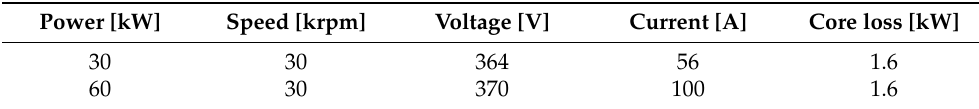
Table 3. Characteristics of 30 krpm electric driven mode.